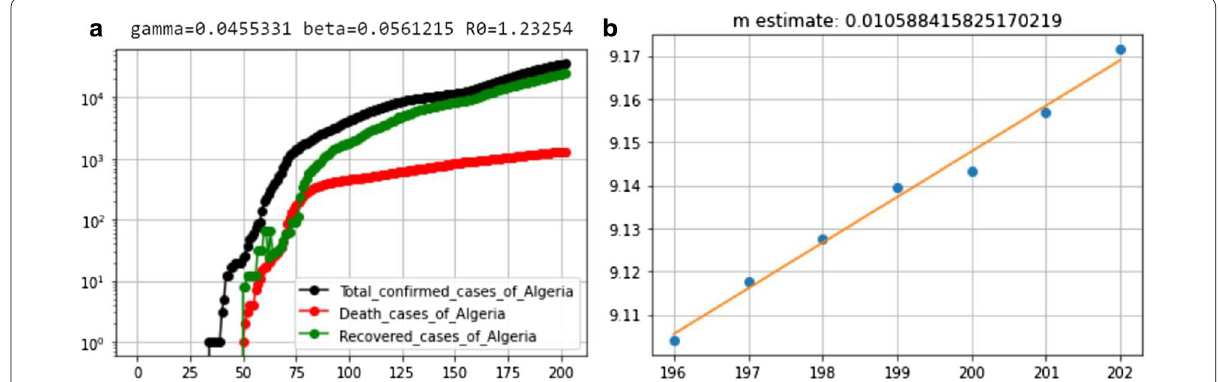
Fig. 4 a Total confirmed cases, deaths and recovered cases in Algeria with “Gamma,” “Beta” and “R 0 ” parameters of SIR model. b Plot for “m” parameter of SIR model in case of Algeria